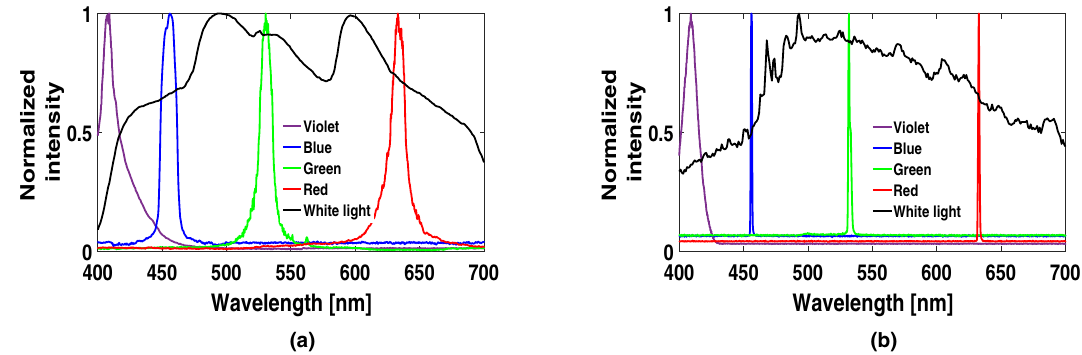
Figure 2. Spectra of four different lasers and Xe-lamp from ( a ) smartphone and ( b ) spectrometer.